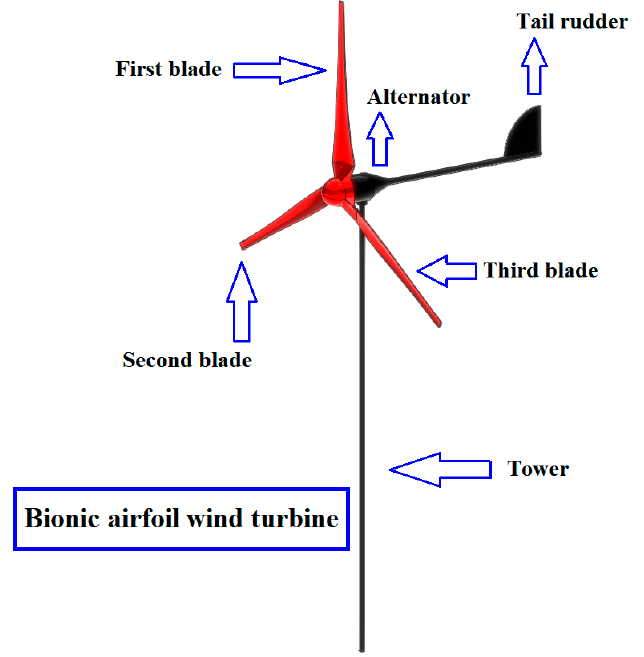
Figure 3. Bionic airfoil wind turbine 3D solid model.